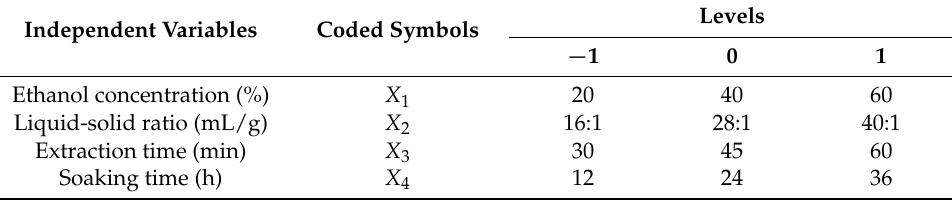
Table 7. Variables and experimental design levels for